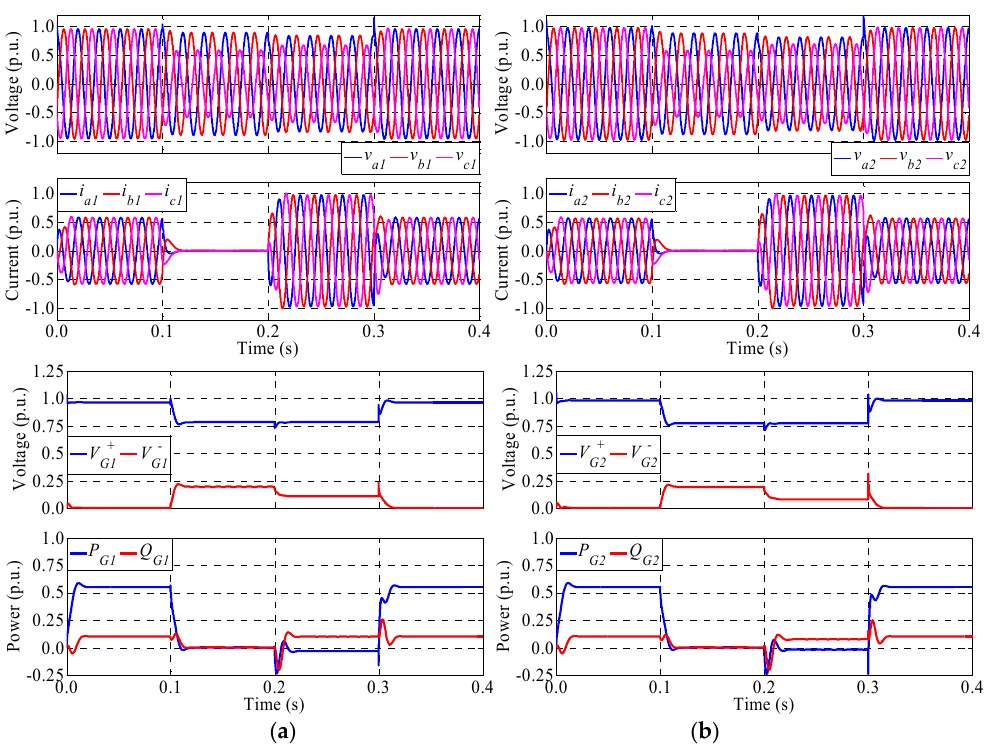
Figure 7. Main waveforms of ( a ) generator 1 and ( b ) generator 2 using the GCCS2 control scheme for type I voltage sag. Energies 2017 , 10 , 2096